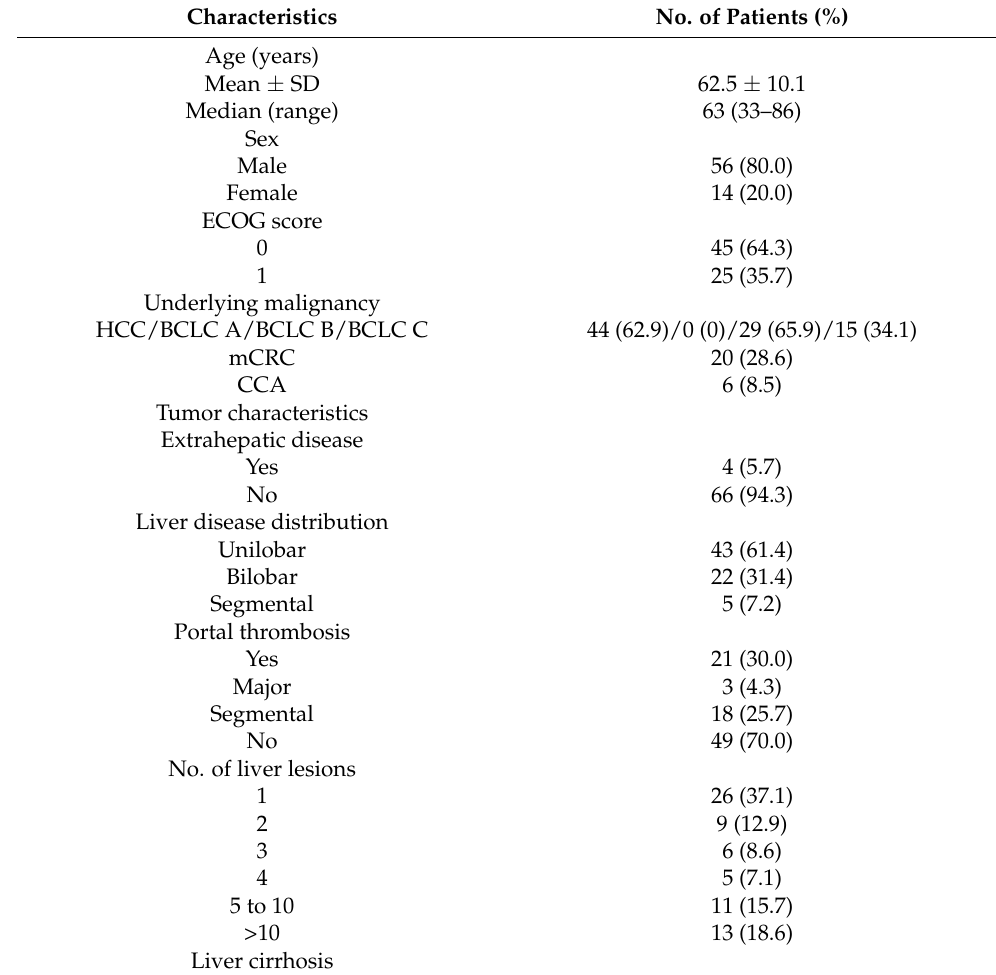
Table 1. Patients’ characteristics.